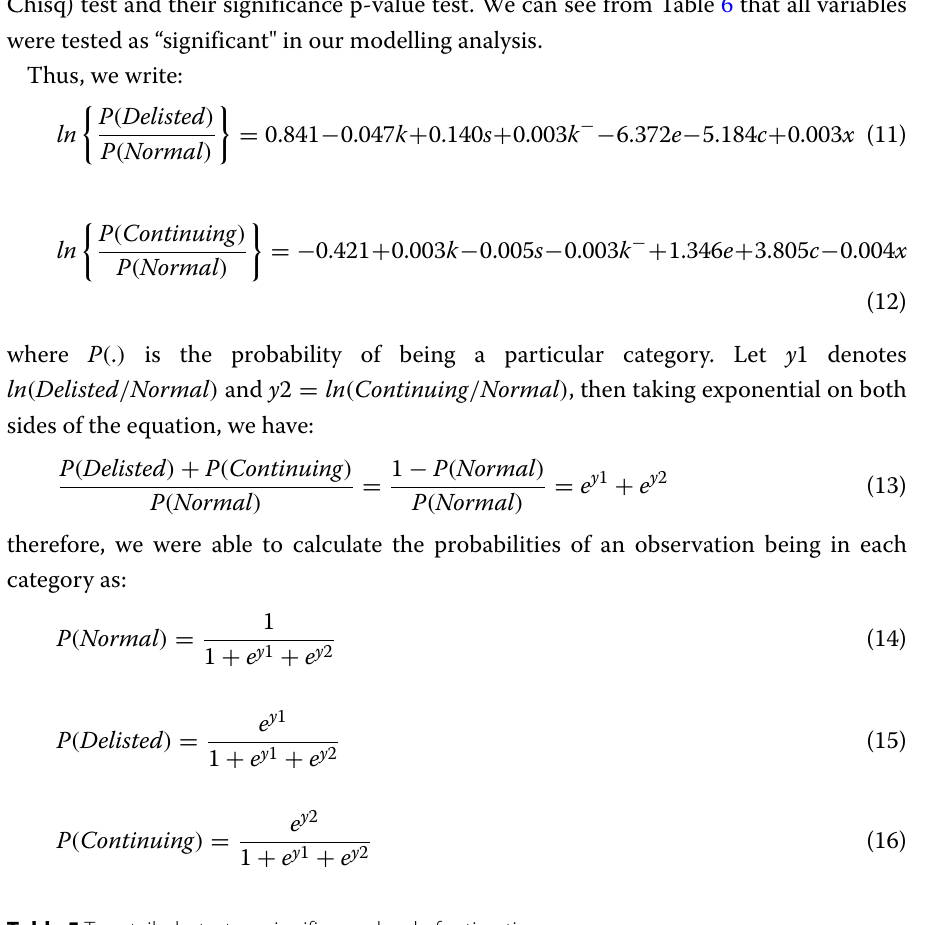
Table 5 Two-tailed z test on significance level of estimations Intercept Degree Strength Neg.degree Eigenvector CC Ave.neighbour.